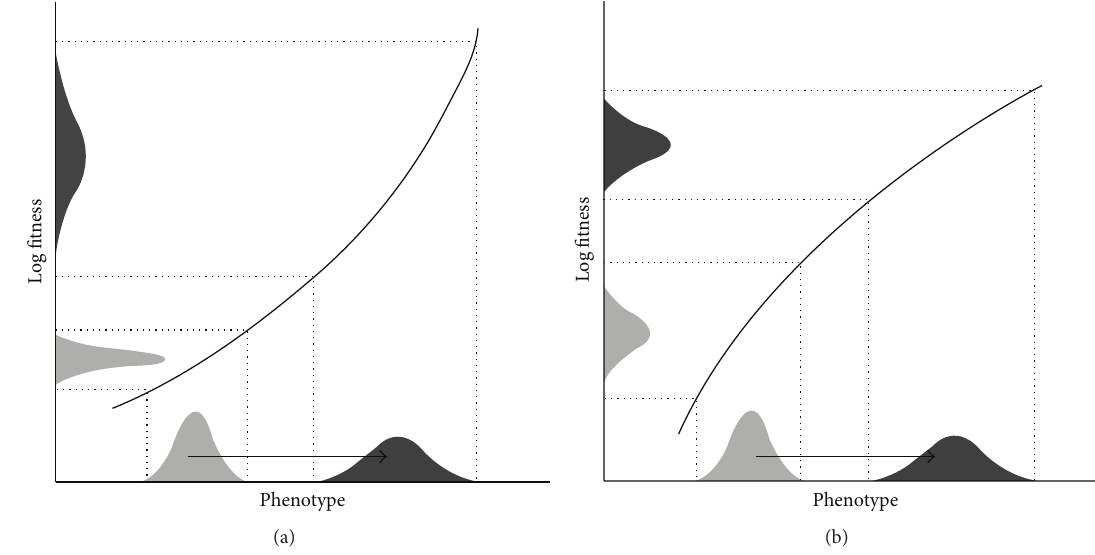
Figure 5: Schematic representation of the directional plasticity effects on the variation in the genotypic values 𝑥 . The solid line shows the log of the fitness function, and the shaded areas symbolize the distributions of phenotypes and fitness without plasticity (light shading) and with plasticity (dark shading). Directional plasticity (symbolized by an arrow) shifts the distribution of the phenotypes (mean and variance). The curvature of the log fitness function (convex in (a); concave in (b)) determines how the shift in the mean of the distribution changes the variation in log fitness from